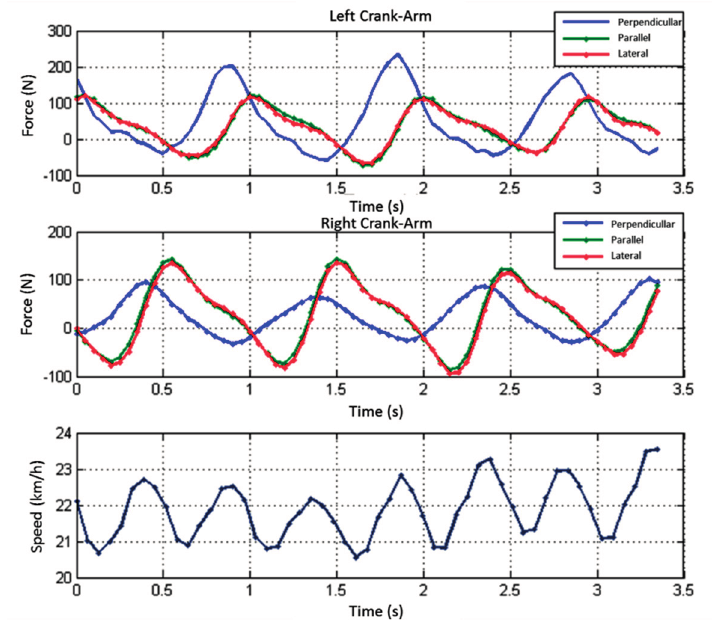
Figure 14. Tests in laboratory: ( a ) Forces and Speed; ( b ) Effectiveness Index; ( c ) Torque and